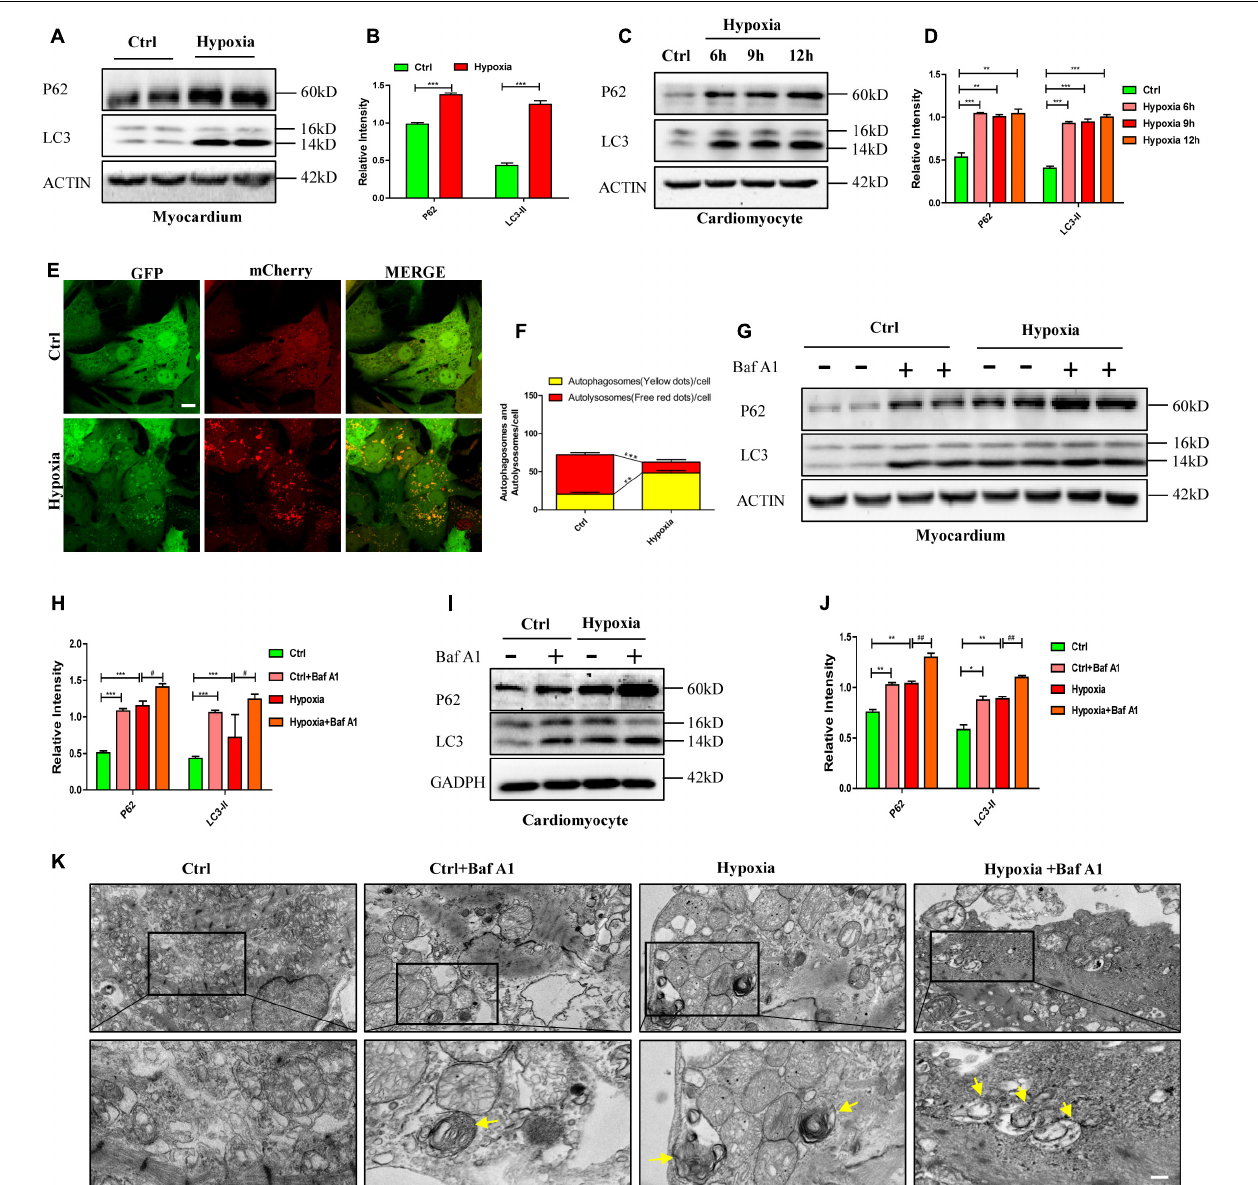
FIGURE 3 | Impaired autophagic flux leads to autophagosome accumulation and necroptosis under hypoxia in vitro and in vivo . (A,B) Representative immunoblotting bands and statistical analysis of p62 and LC3 levels after hypoxia treatment in mouse myocardium. Mean ± SEM, n = 3. *** p < 0.001 versus the control group. (C,D) Representative immunoblotting bands and statistical analysis of p62 and LC3 levels after hypoxia treatment in cardiomyocytes. Mean ± SEM, n = 3. ** p < 0.01, and *** p < 0.001 versus the control group. (E,F) Representative confocal images and statistical analysis of autophagic flux measured by mCherry-GFP-LC3 in cardiomyocytes. Scale bar, 10 µ m, Mean ± SEM, n = 3. ** p < 0.01, and *** p < 0.001. (G,H) Representative immunoblotting bands and statistical analysis of p62 and LC3 levels in mouse myocardium under normoxia and hypoxia with or without bafilomycin A1 (Baf A1). Mean ± SEM, n = 3. *** p < 0.001 and # p < 0.05. (I,J) Representative immunoblotting bands and statistical analysis of p62 and LC3 levels in normoxia and hypoxia cardiomyocytes with or without Baf A1. Mean ± SEM, n = 3. * p < 0.05, ** p < 0.01 versus the control group and ## p < 0.01 versus the hypoxia group. (K) Representative images of autophagosomes analyzed by transmission electron microscopy (TEM) in cardiomyocytes exposed to normoxia and hypoxia with or without Baf A1. Yellow arrow indicates the autophagosome. Scale bar, 0.5 µ m, n =